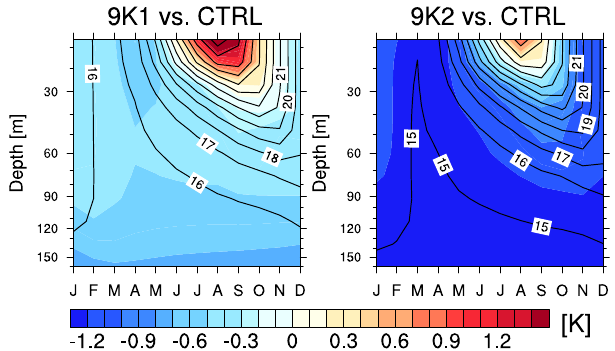
Fig. 10. Anomalies in monthly seasonal cycle of upper ocean tem- perature averaged over the Eastern Mediterranean, 9K1 vs. CTRL (left) and 9K2 vs. CTRL (right); isolines represent the absolute val- ues in ◦ C for 9K1 (left) and 9K2 (right).